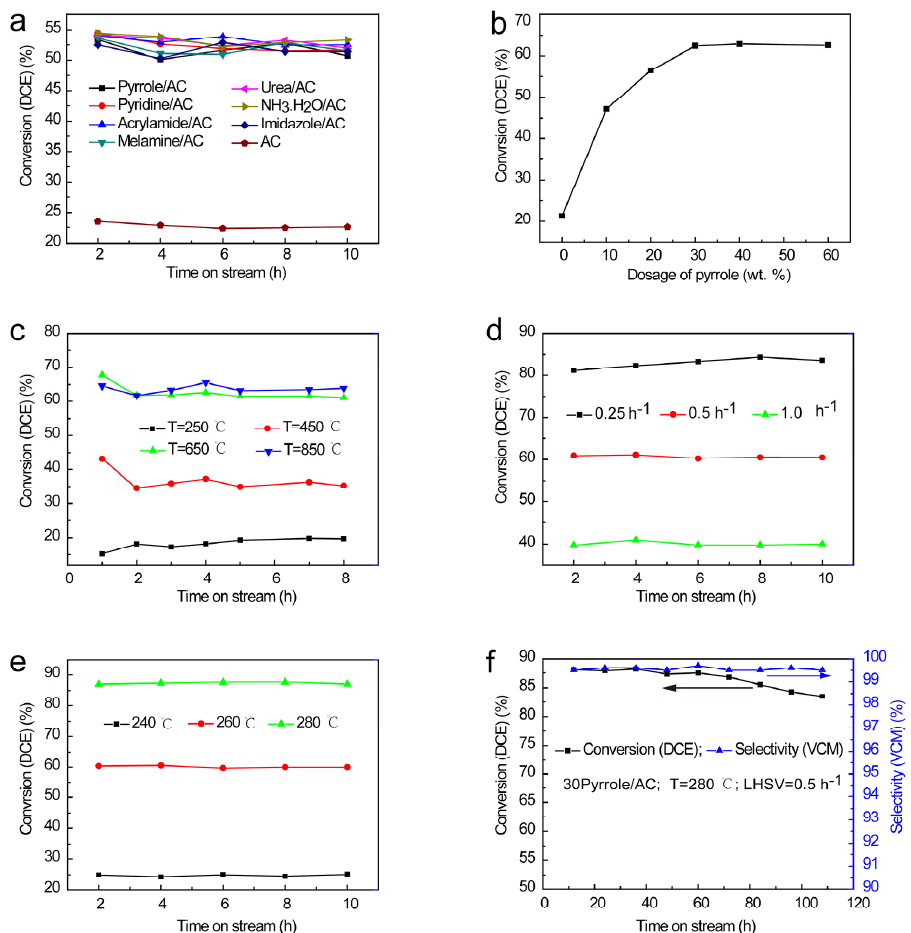
Figure 1. Effects of ( a ) nitrogen precursor species and ( b ) nitrogen content on N@AC catalytic performance. Conditions: 260 °C, liquid hour space velocity (LHSV) 0.5 h − 1 , 1 atm. ( c ) Effect of calcination temperature on N@AC catalytic performance. Conditions: 30Pyrrole/AC, 260 °C, LHSV